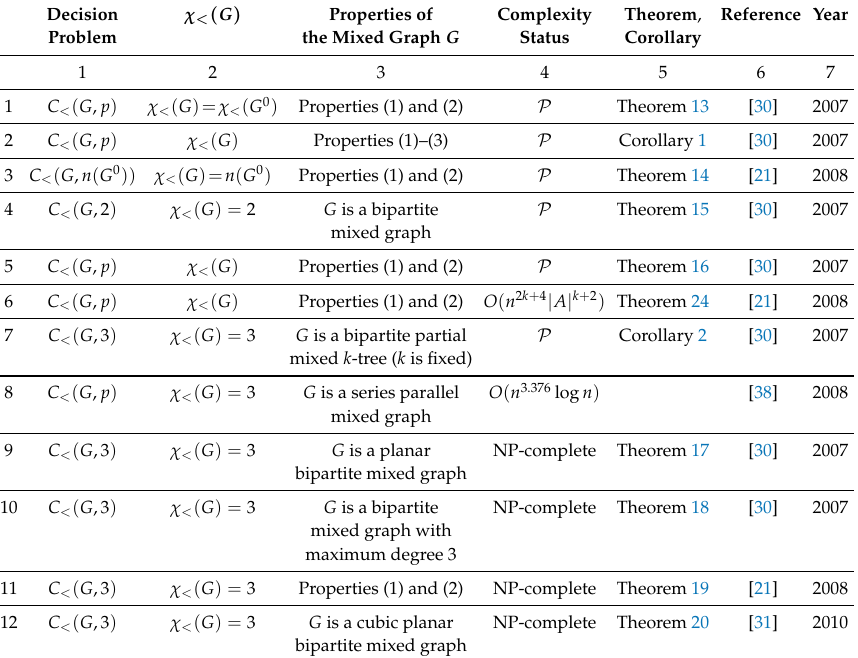
Table 2. The complexity of optimal c < -colorings of the mixed